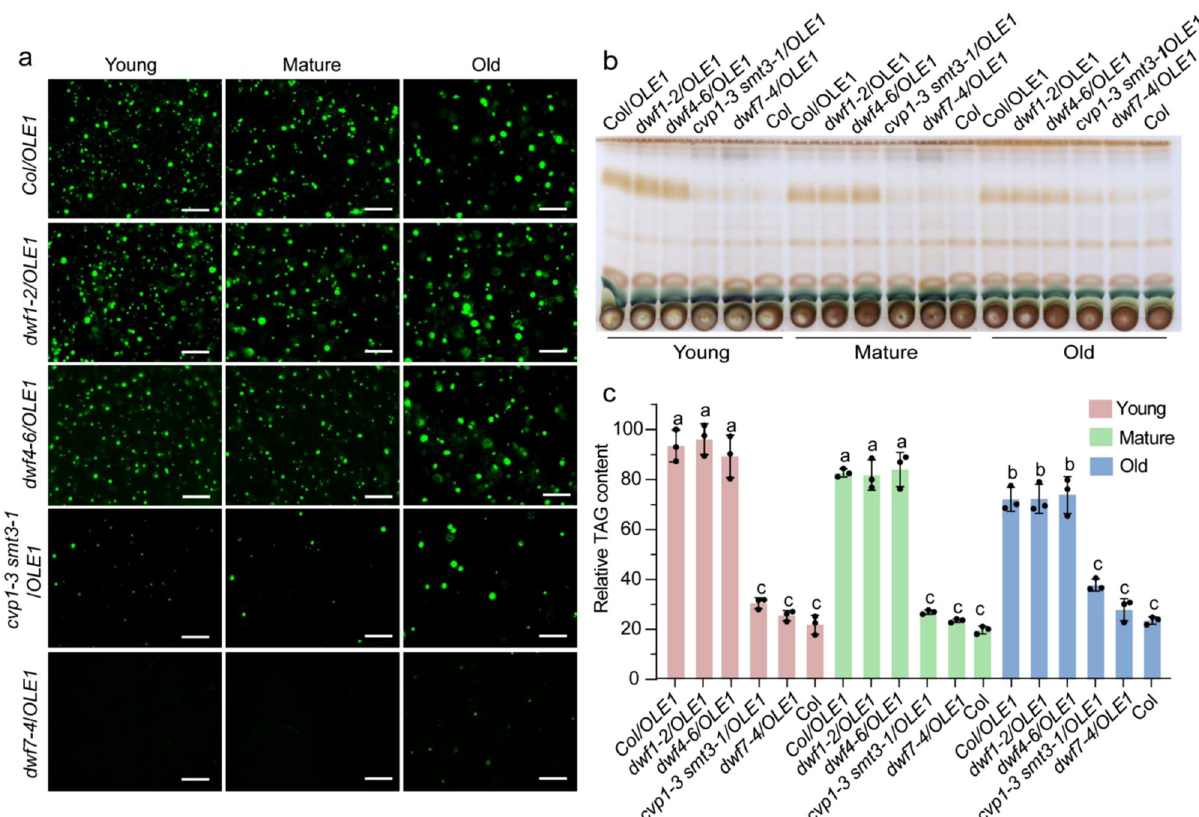
Fig. 3 Disruption of DWF7 or SMT2/3 but not DWF1 and DWF4 results in defects in TAG and LD accumulation in leaves. a Representative images of LDs (OLE1-GFP, green) in young, mature, and old (for de fi nitions, see Fig. 1) leaves of 4-week-old plants. The experiment was repeated four times with similar results. Bar = 50 μ m. b , c TLC analysis of neutral lipids. Lipids were isolated from leaves of 4-week-old plants and visualized with 5% sulfuric acid by charring ( b ). Relative contents of TAG were quanti fi ed by Image J ( c ). Data are mean ± SD of three biological replicates. Different letters indicate signi fi cant differences at P < 0.05, as determined by one-way ANOVA with Tukey ’ s multiple comparisons